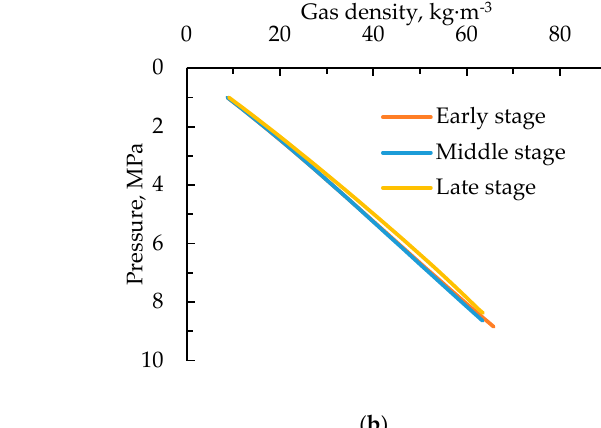
Figure 7. ( a ) The change in critical gas velocity in different periods; ( b ) the change in liquid–gas density in different periods.